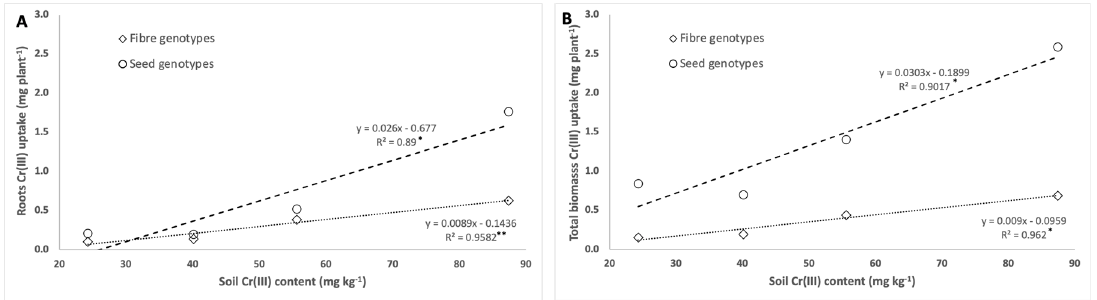
Figure 5. Regressions between soil Cr content and roots Cr uptake ( A ) and plant Cr uptake ( B ) as a function of hemp type. Significance level of the regression lines is shown at * p < 0.05 and ** p <